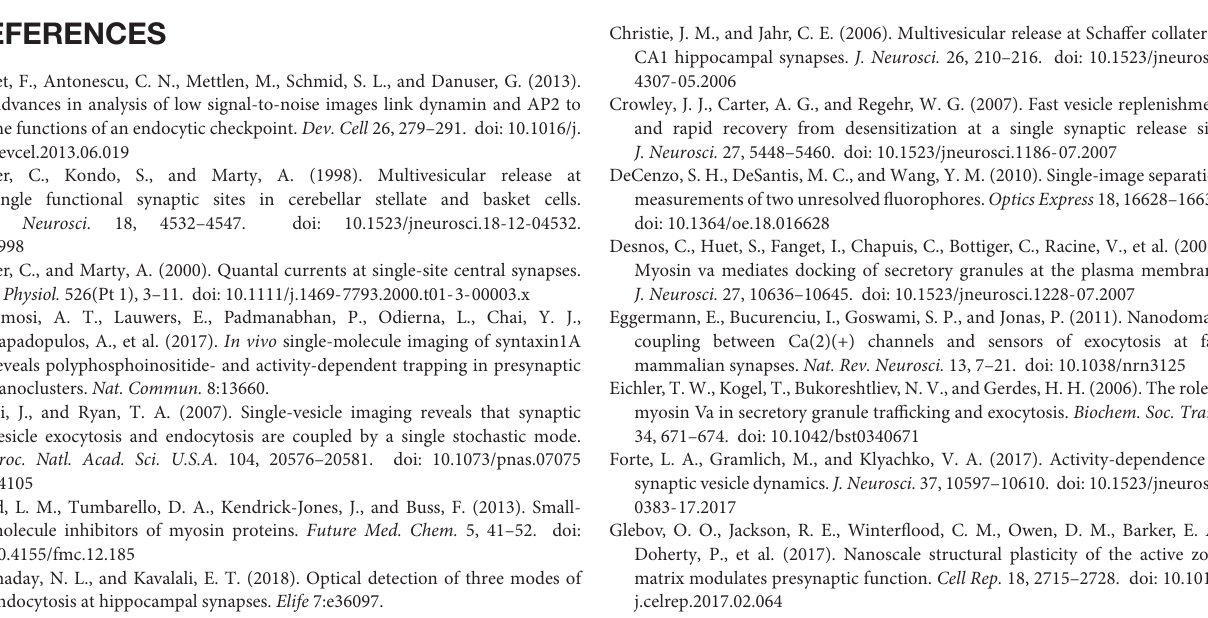
Supplementary Figure 3 | Effects of myosin V inhibition with PBP on the utilization of release sites engaged in MVR. (A) Effect of myosin V inhibition with PBP (brown) on reuse of release sites engaged in MVR events. Reuse was quantified as the percentage of release sites engaged in MVR that are reused at least once during the 120 s observation period by either other MVR or UVR events. The reuse probability is highly dependent on the distance to AZ center; to account for this variability, we use a paired t -test with data binning at 50 nm. (B,C) Effect of myosin V inhibition with PBP (brown) on the spatial overlap of MVR and UVR events determined by the proximity analysis. Percentages of MVR events in which none (red), one (blue), or both (black) events in the pair occurred within ± 25nm of at least one UVR event (i.e., at the same at release site) during the observation period (B) , and quantification of the percentage of no overlap of MVR and UVR events (C) . Two-sample t -test (A) or Barnard’s test (C) . ∗∗ p < 0.01, ns, not significant. Supplementary Figure 4 | Effects of myosin V inhibition with PBP on the temporal separation within MVR events. (A,B) Effect of myosin V inhibition with PBP on the amplitude difference of the two events comprising MVR as a function of intra-event distance. Linear fit (A) and t -test of pooled data (B) are shown. (C) Quantification of the effects of PBP in panels (A,B) assessed by comparing the slopes of the correlations. Two-sample t -test (B) . One-way analysis of covariance (C) . ∗ p < 0.05; ns, not significant. Supplementary Table 1 | Table of all data values and statistical analyses. Data table columns are formatted as (i) corresponding figure location; (ii) conditions being statistically compared and separated by “/”; (iii) measurement; (iv) number of samples (synapses, dishes, and cultures) used for each test; (v) mean values and errors for each condition separated by “/” and corresponding to conditions in column (i); (vi) statistical test used for comparison; and (vii) P -value resulting from the statistical